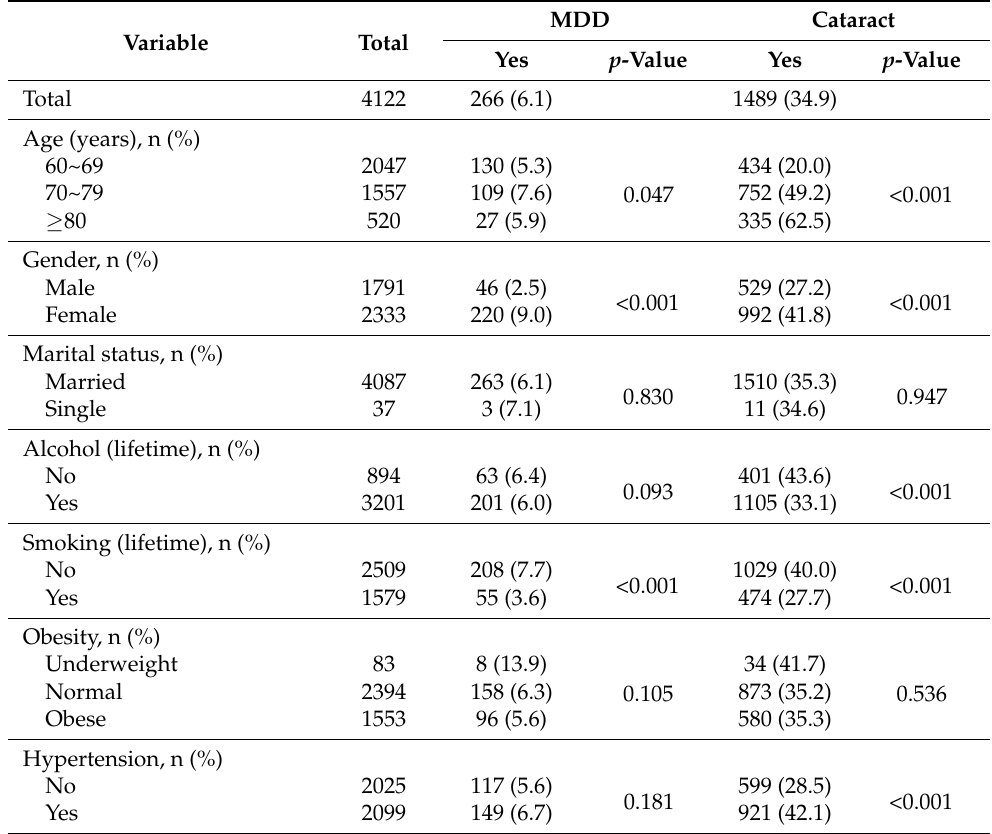
Table 1. The prevalence of major depressive disorder (MDD) and cataracts according to general characteristics and disease conditions (N =